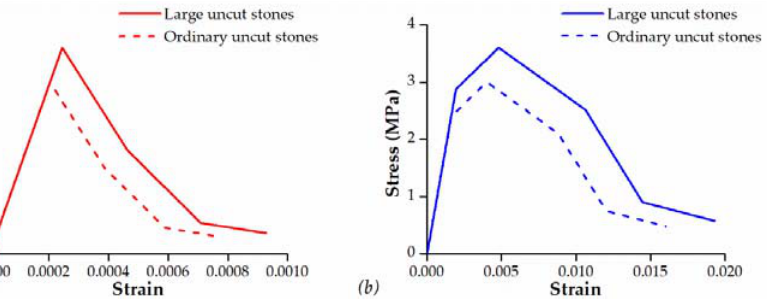
Table 2. Mechanical parameters of the CDP model.